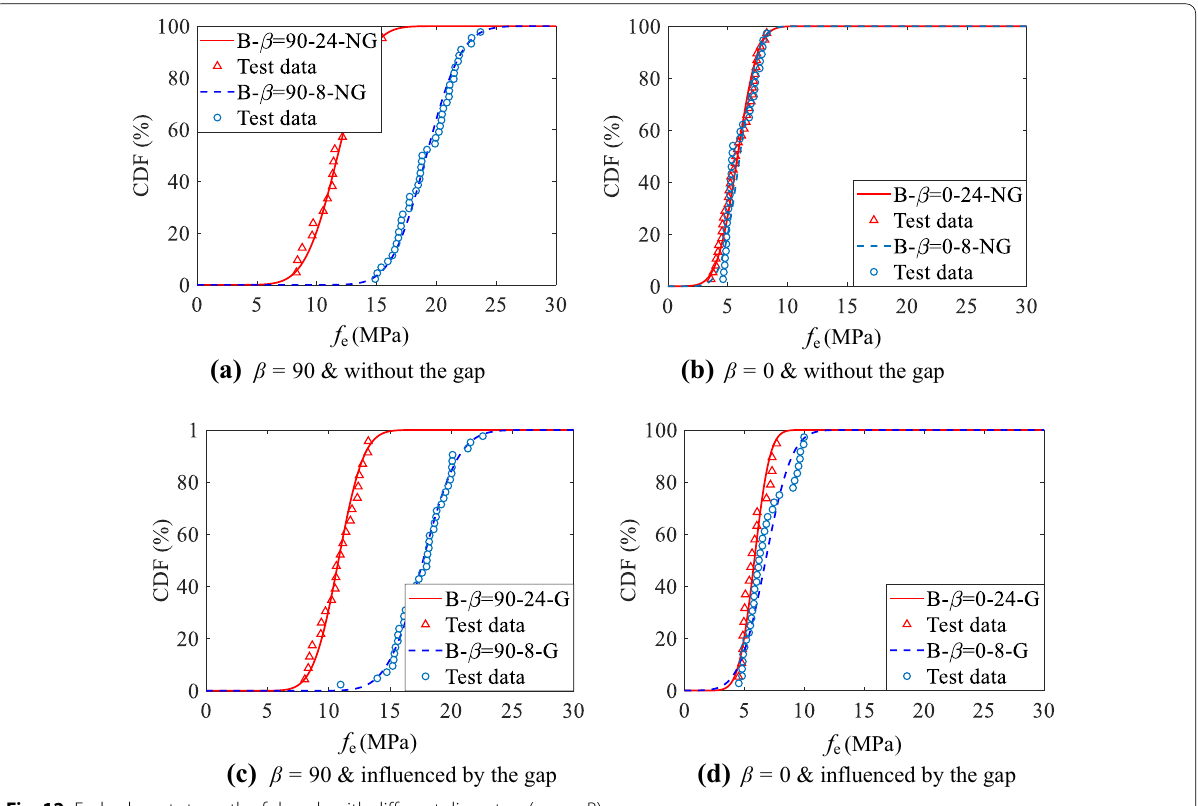
Fig. 12 Embedment strength of dowels with different diameters (group